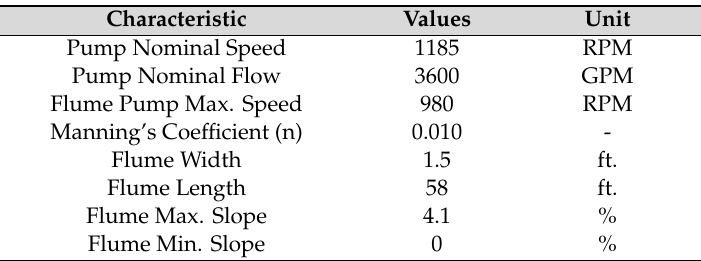
Table 5. Flume characteristics.